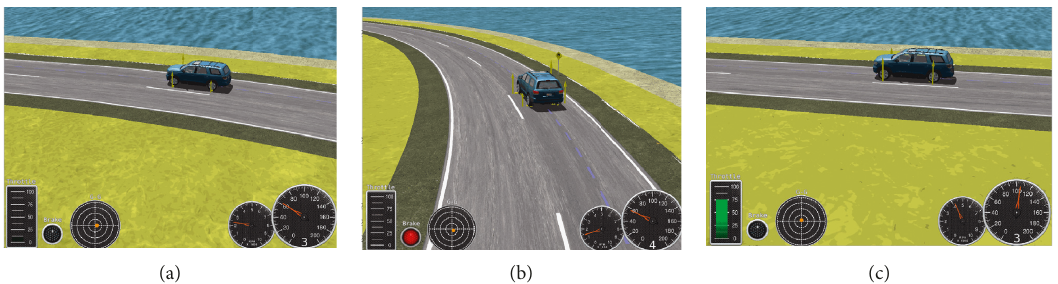
Figure 10: Braking simulation: (a) constant speed; (b) brake deceleration; (c) acceleration